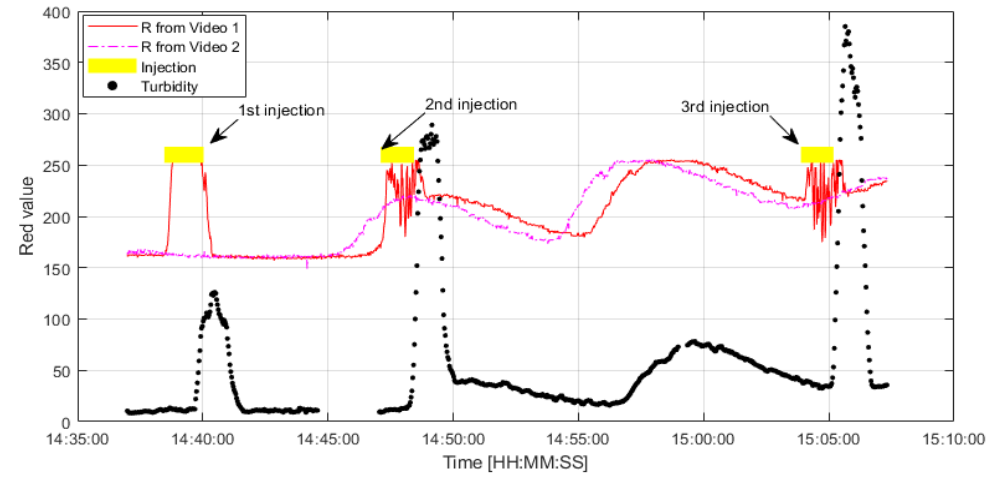
Figure 9. Red value changes in the underwater images captured by Video 1 (at 18 m) and Video 2 (at 31.8 m).